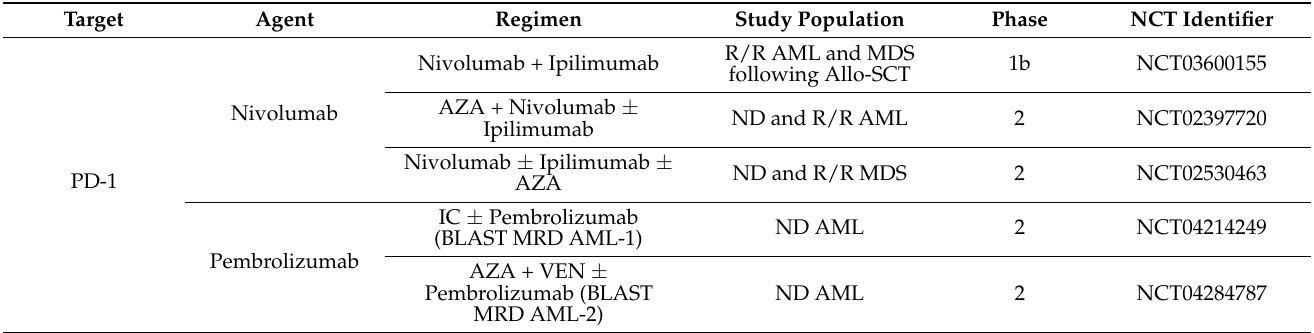
Table 1. Overview of Ongoing Trials of Immune Checkpoint Inhibitors in Acute Myeloid Leukemia and Myelodysplastic